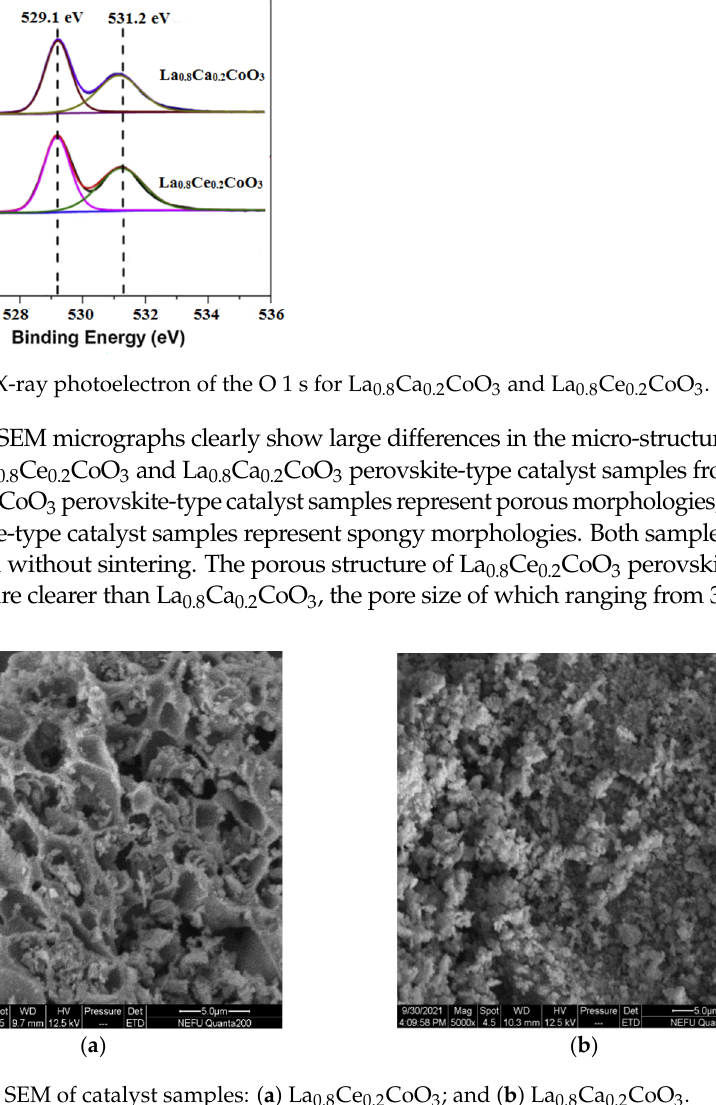
0.8 Ce 0.2 CoO 3 ; and ( b ) La 0.8 Ca 0.2 CoO 3